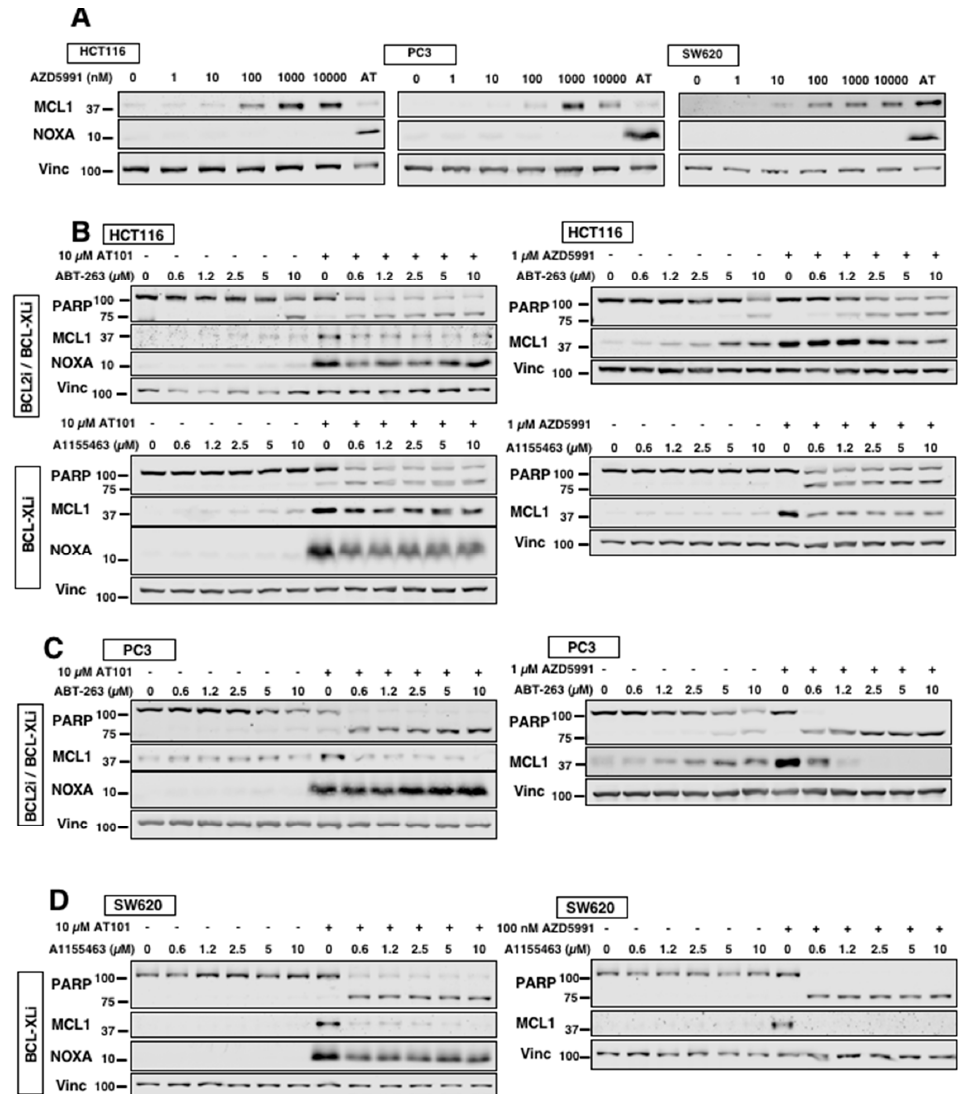
Figure 4. Comparison of AT101 to MCL1 inhibitor AZD5991. ( A ) The indicated cell lines were incubated with AZD5991 for 24 h and analyzed for NOXA and MCL1 protein expression. A 6 h incubation of AT101 (AT) was used as a positive control for NOXA induction. ( B–D ) The indicated cell lines were incubated with either 10 μ M AT101 or 0.1–1 μ M AZD5991 in combination with either ABT-263 or A1155463 for 24 h and analyzed for PARP cleavage, NOXA and MCL1 protein expression.